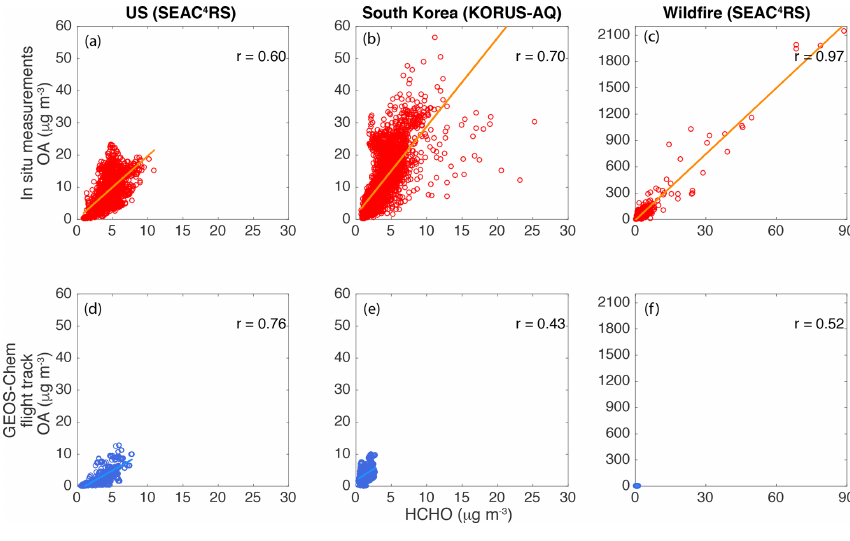
4 Comparison of OA–HCHO relationships: in situ